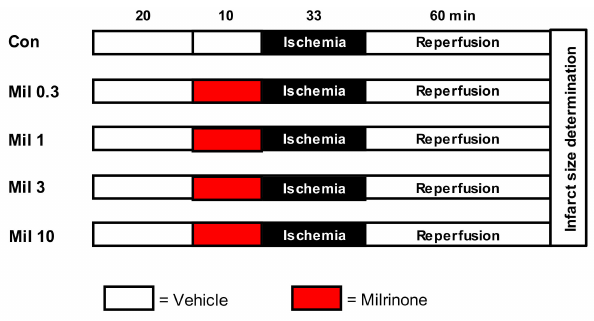
Figure 1. Experimental scheme from part one of the study: Con = Control; Mil =